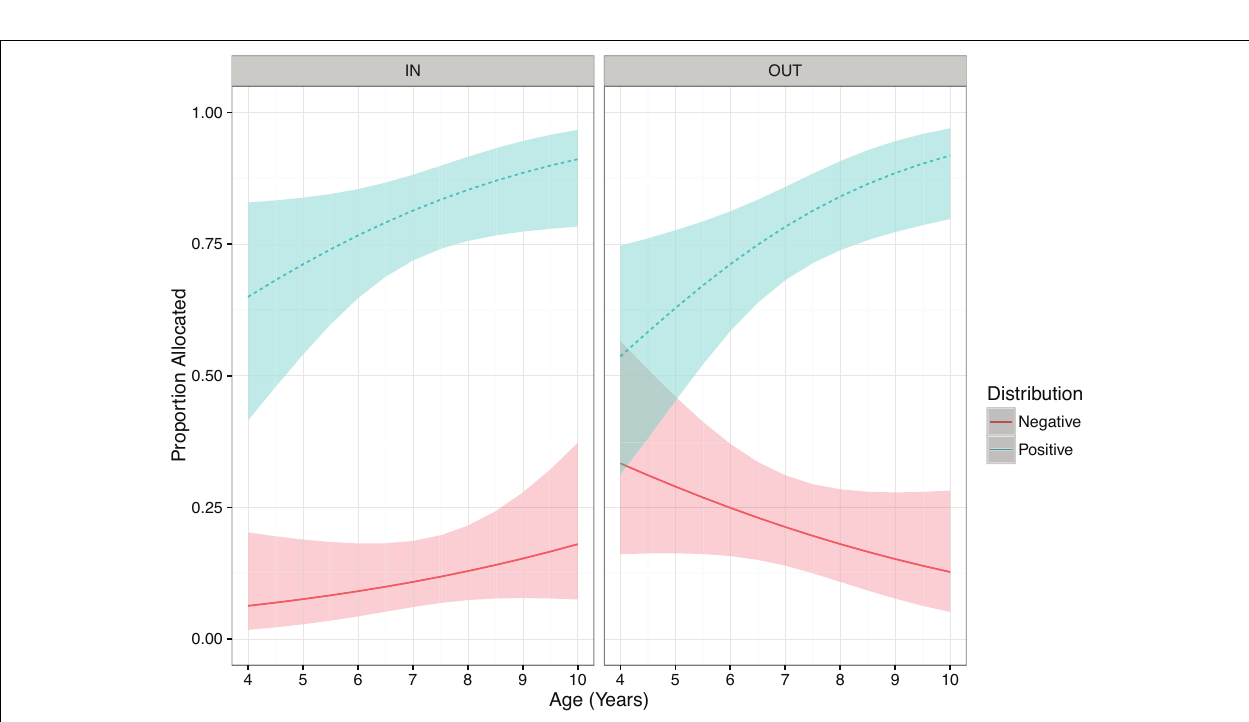
Frontiers in Psychology |